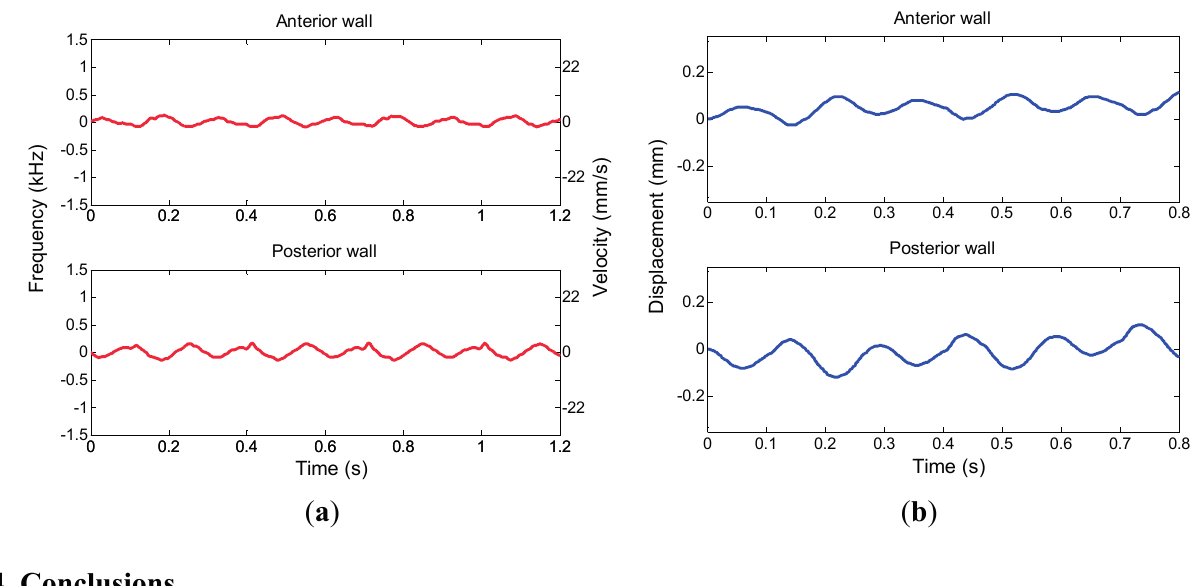
Figure 9. Velocity profiles ( a ) and displacements ( b ) of the anterior and posterior wall motion derived from the multigate Doppler